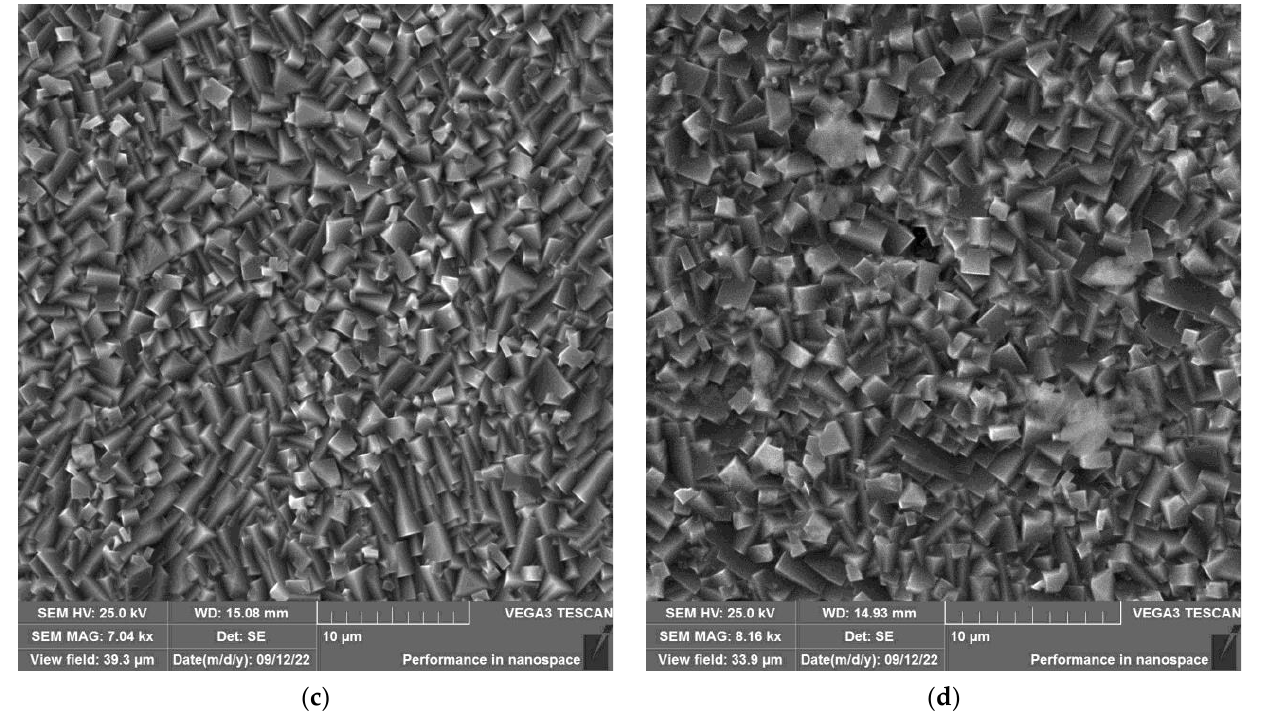
Figure 9. Surface of disk specimen № 7 (T irr = 390 °C, Table 4) at different magnifications after autoclave SCC tests with a load value of 423 N (before crack opening loading).